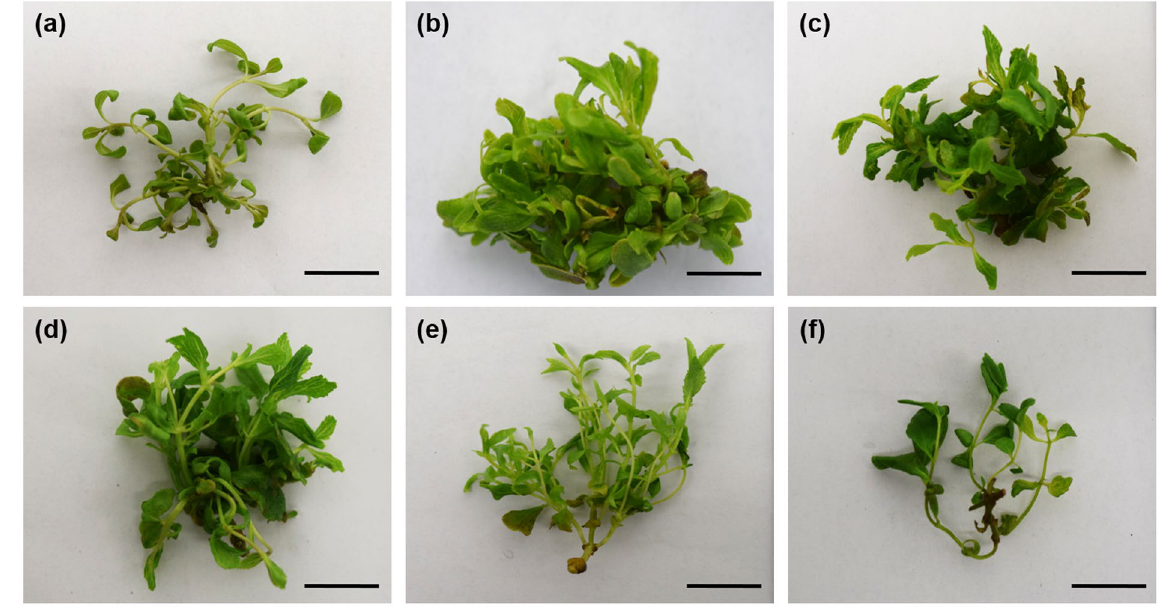
Figure 3. Effect of Silver nanoparticles on in vitro multiplication of stevia ( Stevia rebaudiana B.) after 30 days of culture in Temporary immersion systems (TIB). ( a–f ) 0, 12.5, 25, 50, 100 y 200 mg L − 1 of Argovit, respectively. Bar = 1 cm.